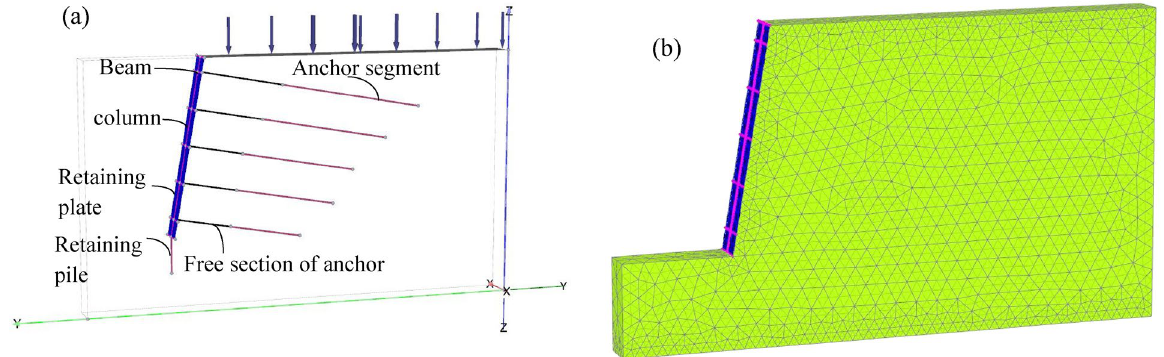
Figure 4. Finite element numerical model: ( a ) Model establishment ( b ) Mesh